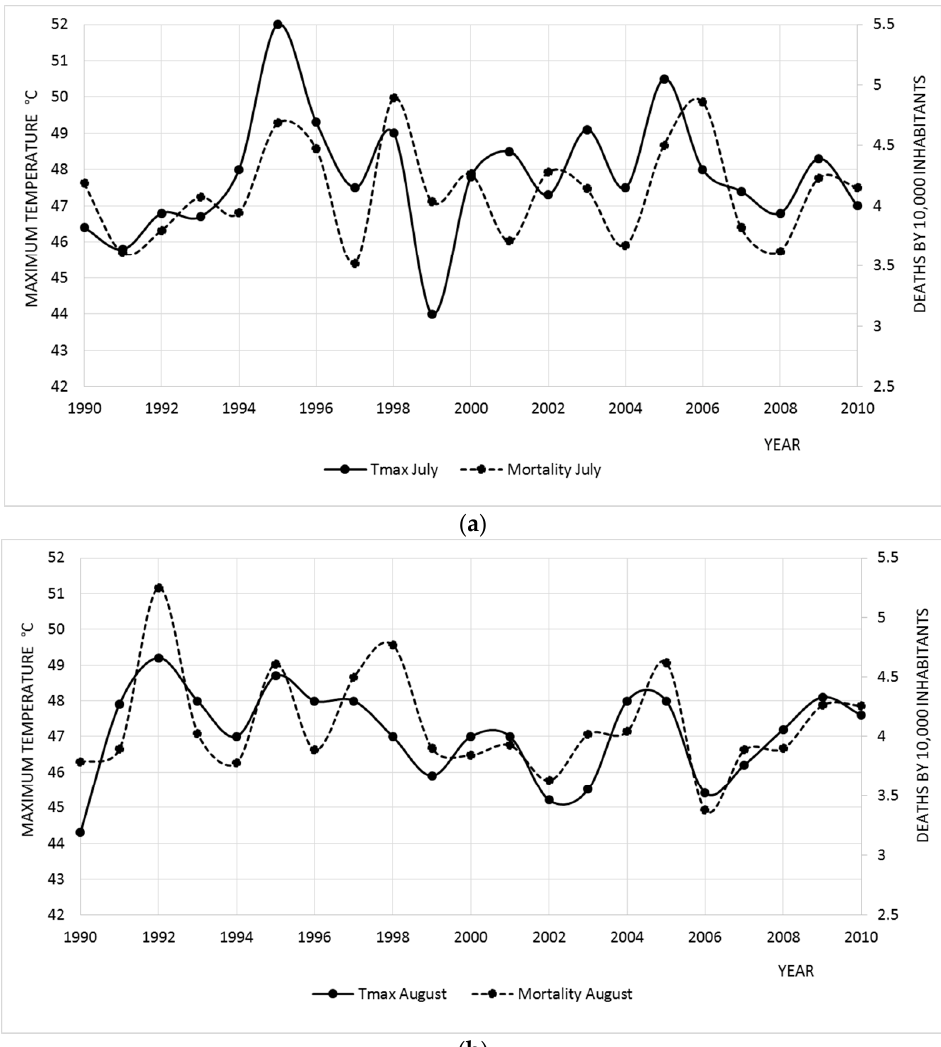
Figure 9. Mortality rate by 10,000 inhabitants for July ( a ), August ( b ), and September ( c ), 1990–2010 in Mexicali, Mexico.